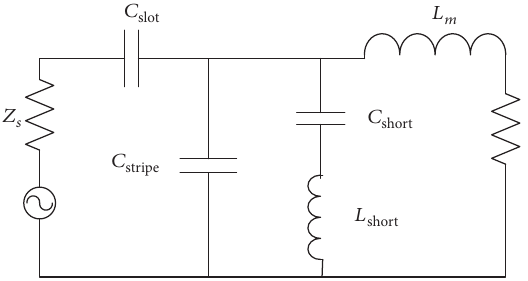
Figure 2: Equivalent circuit model of the proposed antenna.